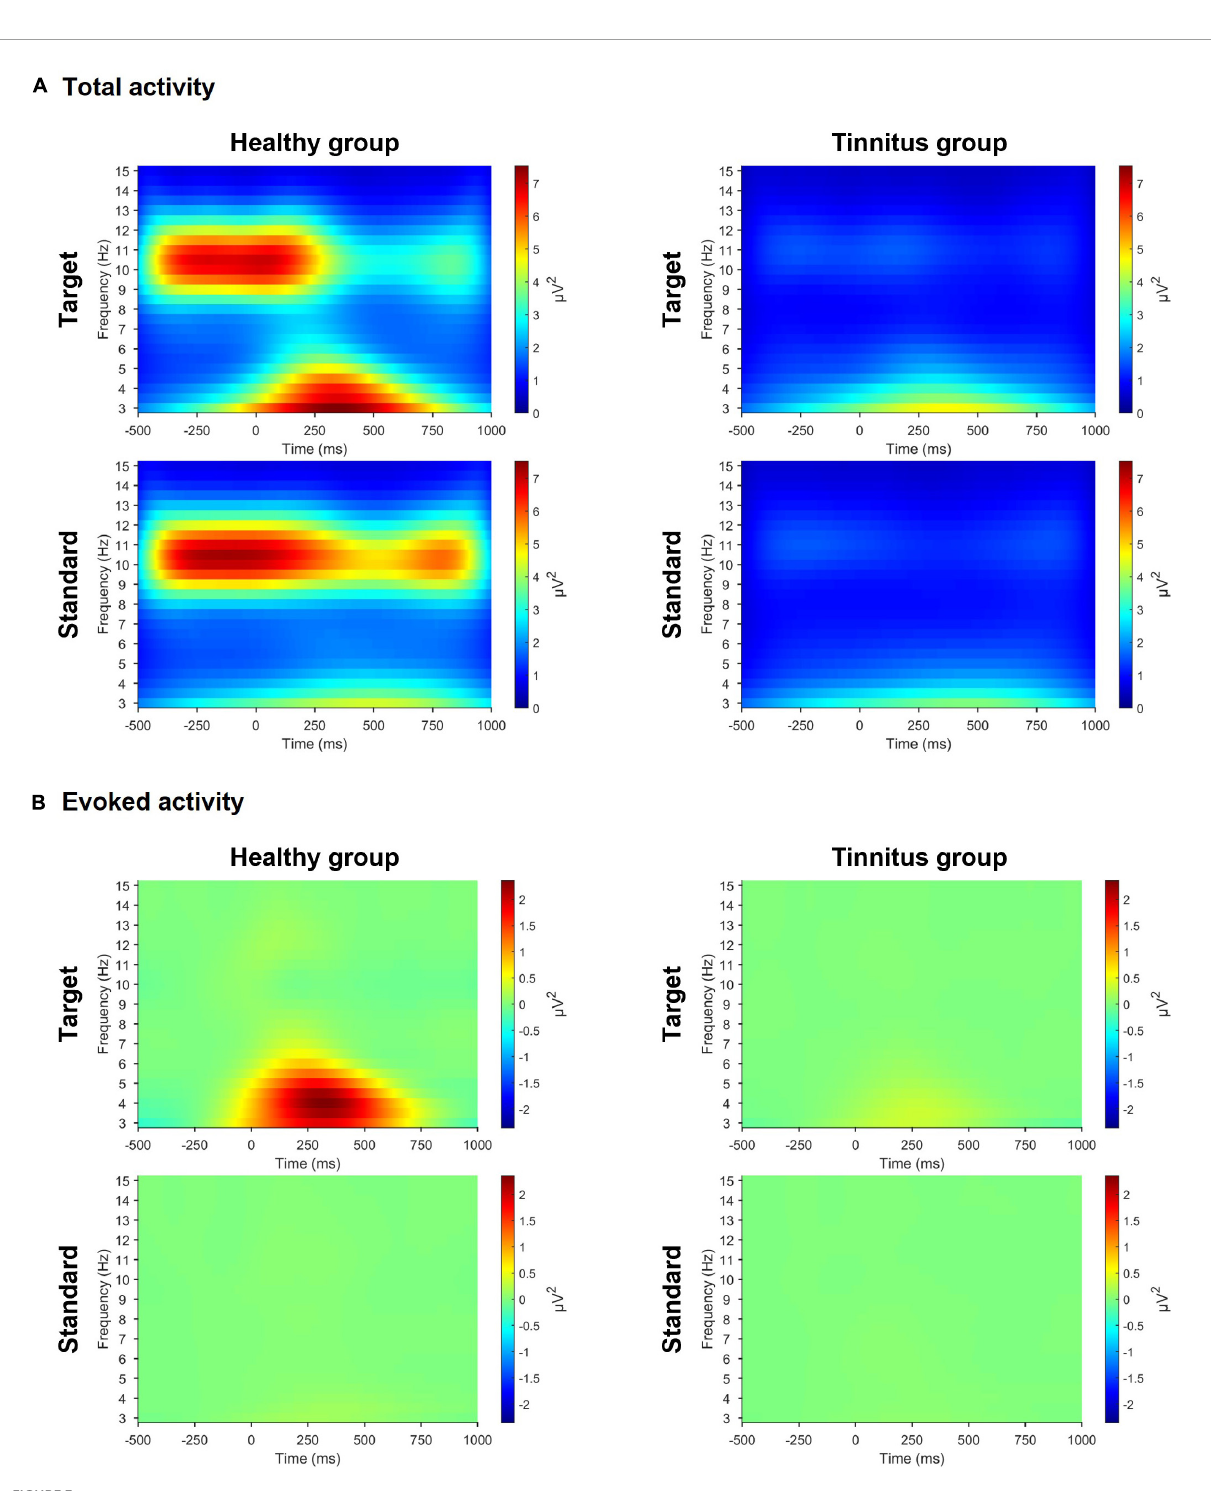
(mean ± standard error; Z = 2.934, p < 0.005) was achieved using the EEG alpha band ( Figure 4A ). The AUCs by the EEGNet indicated marginally better decoding performance than those by